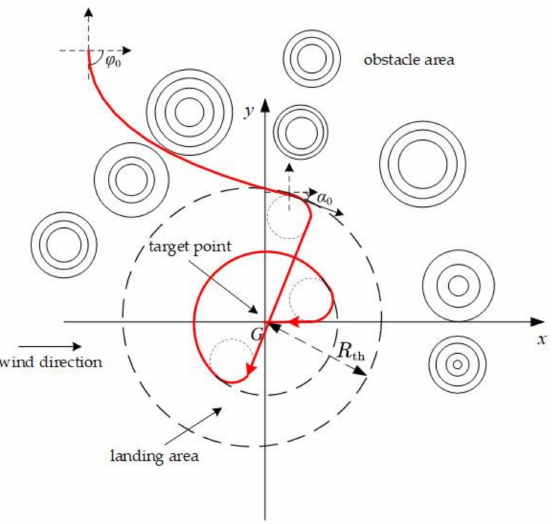
Figure 1. Schematic of a combined parafoil system for homing trajectory planning in a complex